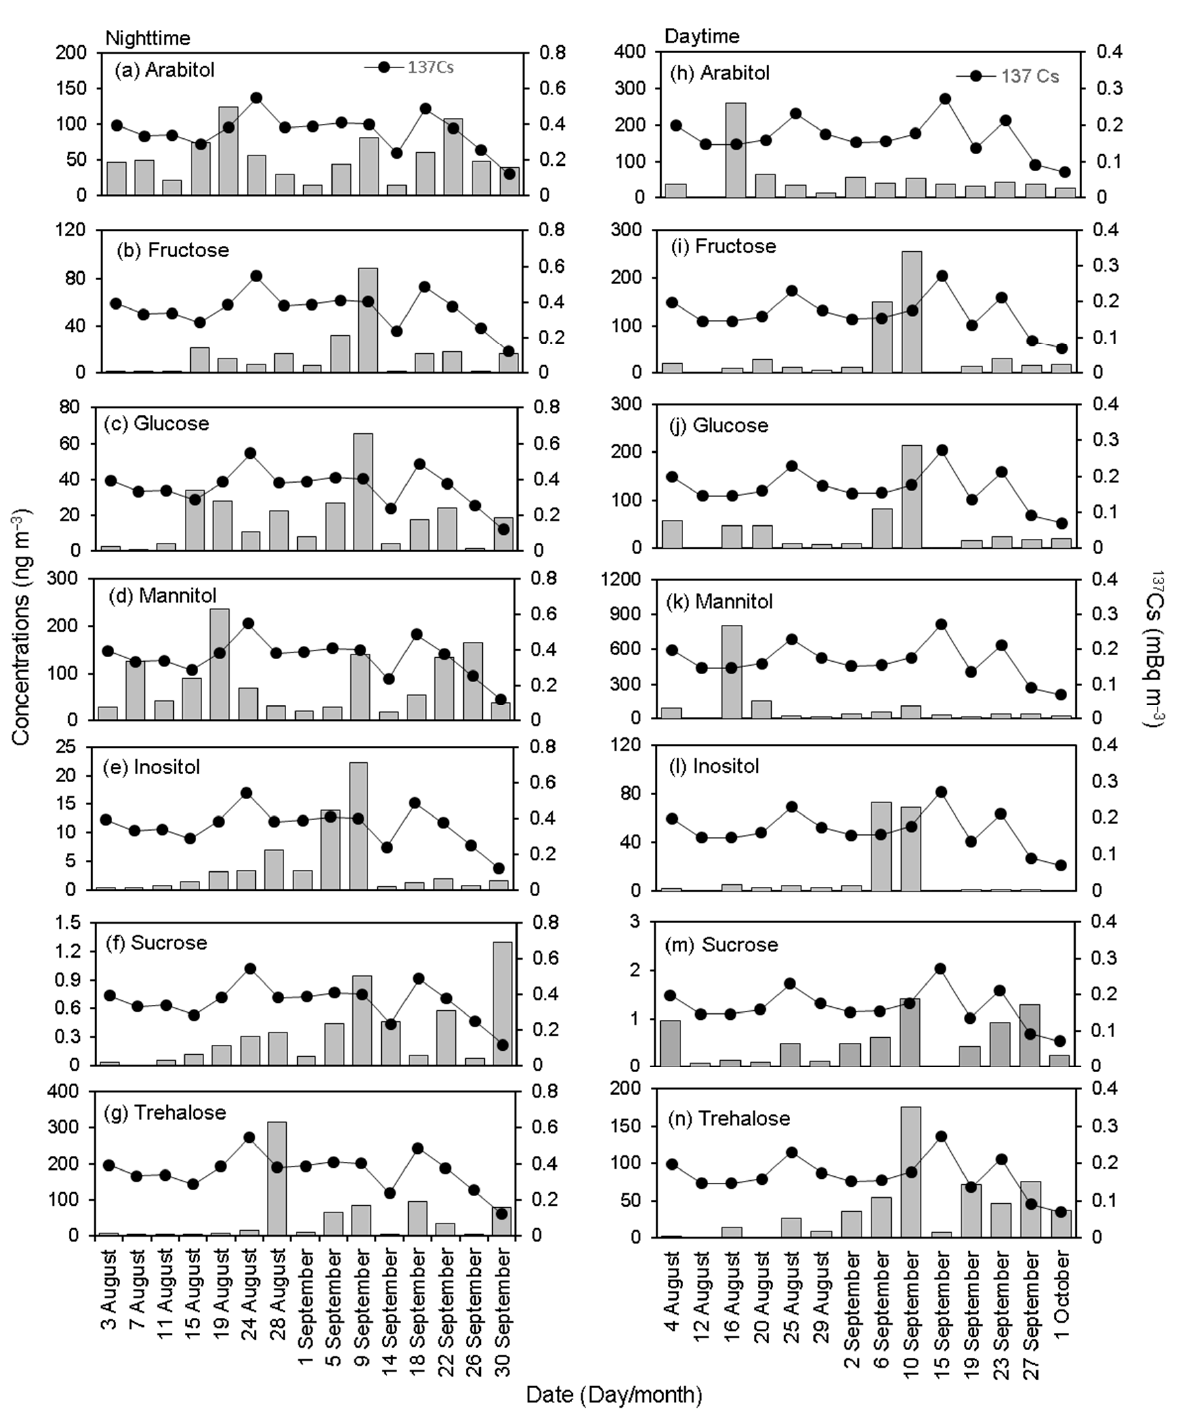
Figure 5. Time series plots of 137 Cs and organic tracers in the ambient aerosols collected from Fukushima during ( a – g ) night- and ( h – n ) daytime periods. The sampling durations were four days. The dates mean the first day of the sampling periods. The data of 8 August are not shown due to the missing of 137 Cs data.